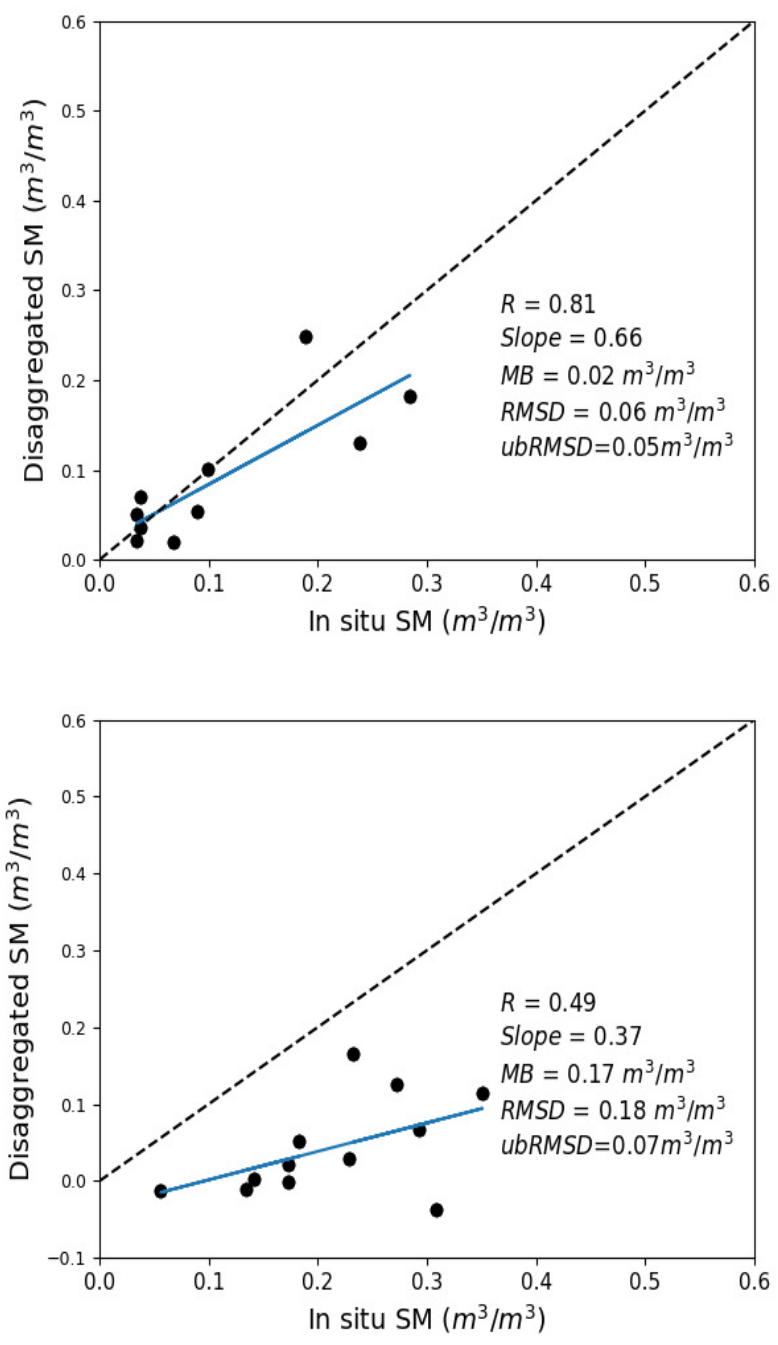
Figure 3. DISPATCH 100 m resolution disaggregated SM versus in situ measurements at Chichaoua ( top ) and Sidi Rahal ( bottom )